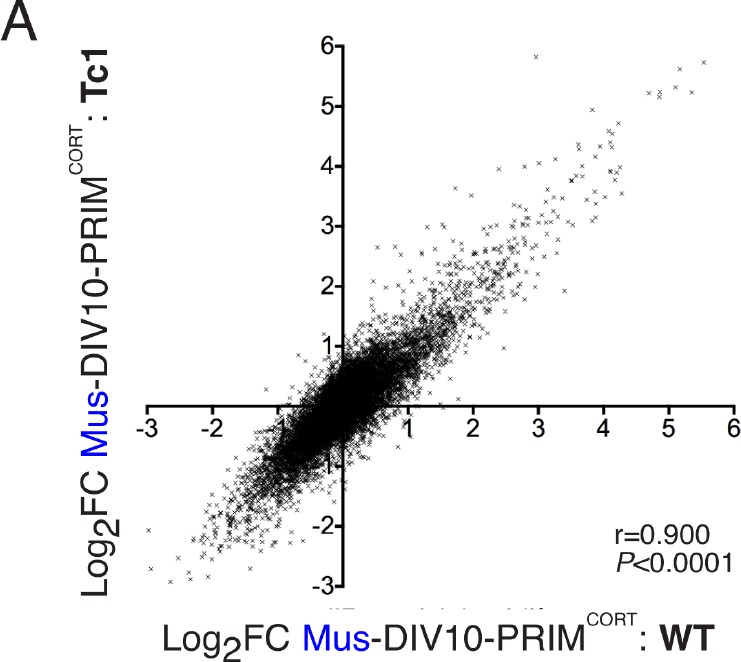
Inducibility of mouse genes in wild-type and Tc1 neurons strongly correlate.(A) Correlation of KCl/FPL-induced fold-change in the same 11,302 mouse genes analysed in Figures 1 and 2,in DIV10 Mus-ESCCORT-neurons from wild-type vs. Tc1 primary cortical neurons, showing the expected high correlation.